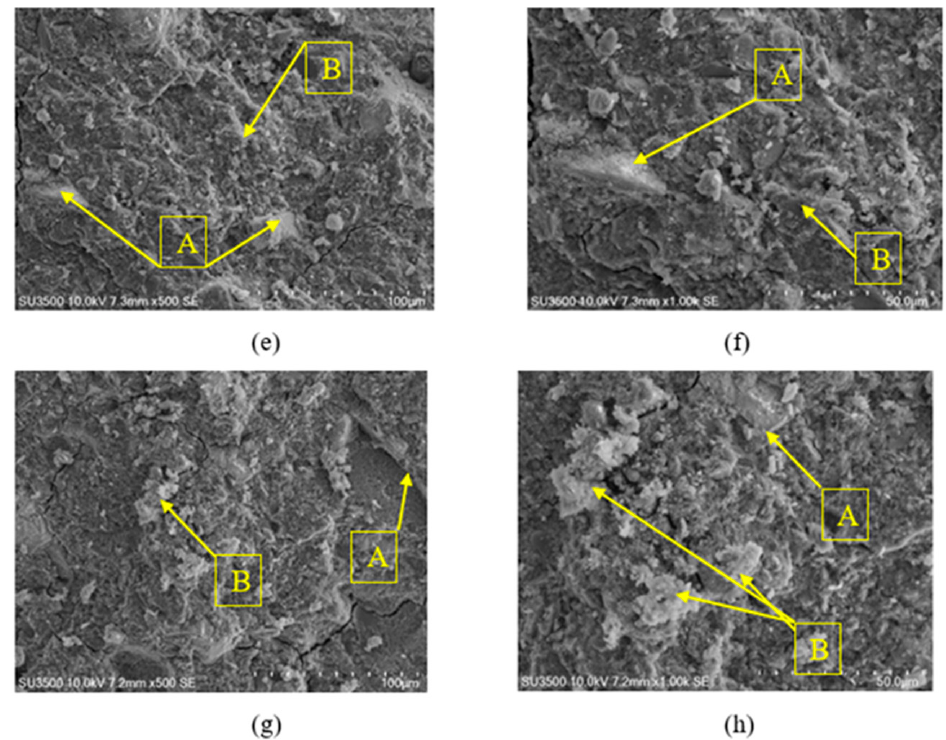
Figure 6. Microstructures of fresh surfaces of the different mortars: ( a ) GP-10RC, 500X; ( b ) GP-10RC, 1000X; ( c ) GP-20RC, 500X; ( d ) GP-20RC, 1000X; ( e ) 90GP0-10RC, 500X; ( f ) 90GP0-10RC, 1000X; ( g ) 80GP0-20RC, 500X; and ( h ) 80GP0-20RC, 1000X. Unreacted waste corundum or partially reacted particles and sponge-like geopolymer gels are denoted by “A” and “B”,